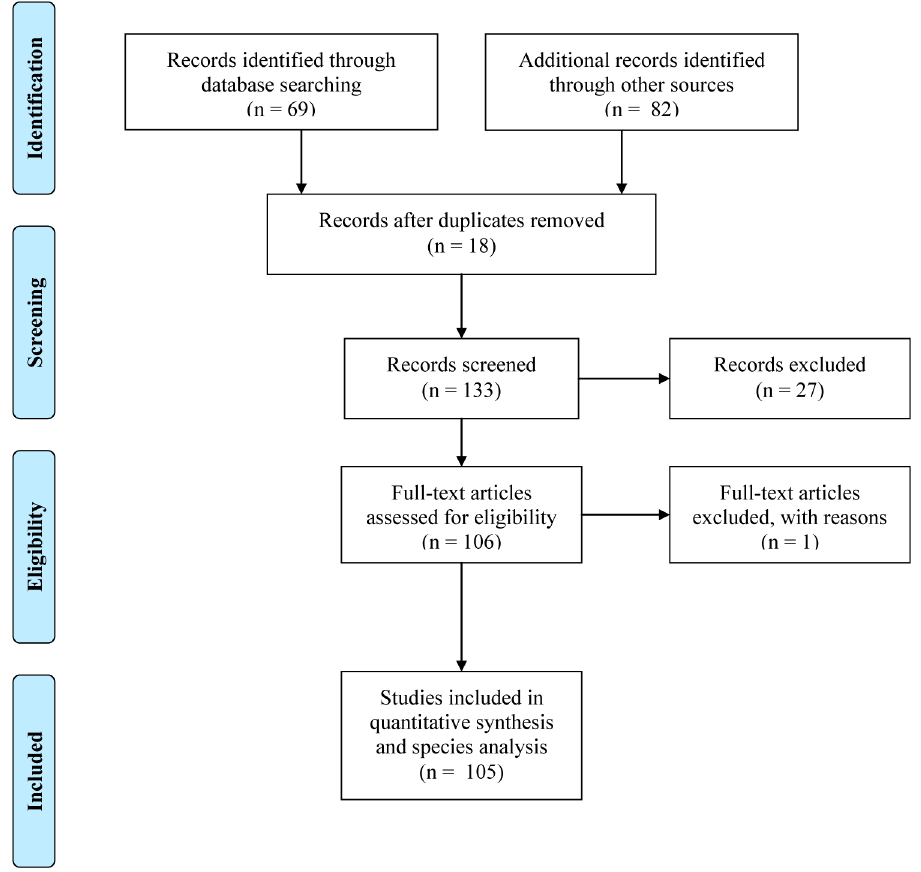
Fig 1. Flow chart using the Preferred Reporting Items for Systematic Reviews and Meta-Analyses